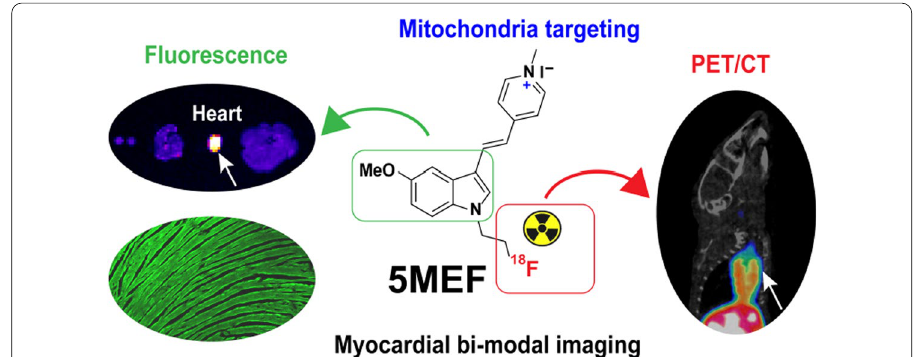
Fig. 6 Chemical structure of [ 18 F]5MEF and its application in myocardial bimodal imaging. Reprinted